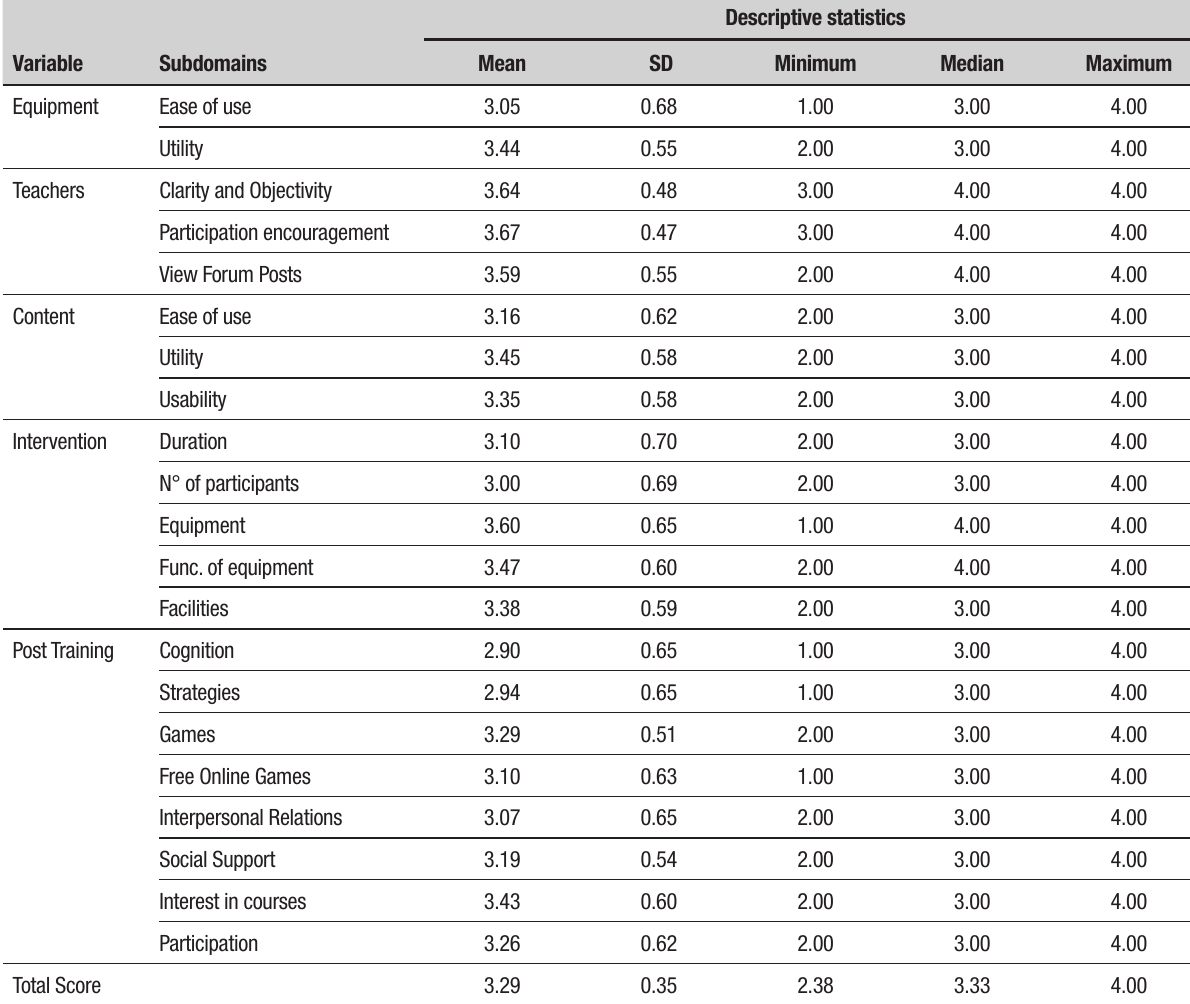
Table 4. Satisfaction, evaluation and attitudes regarding training on games for Training Group